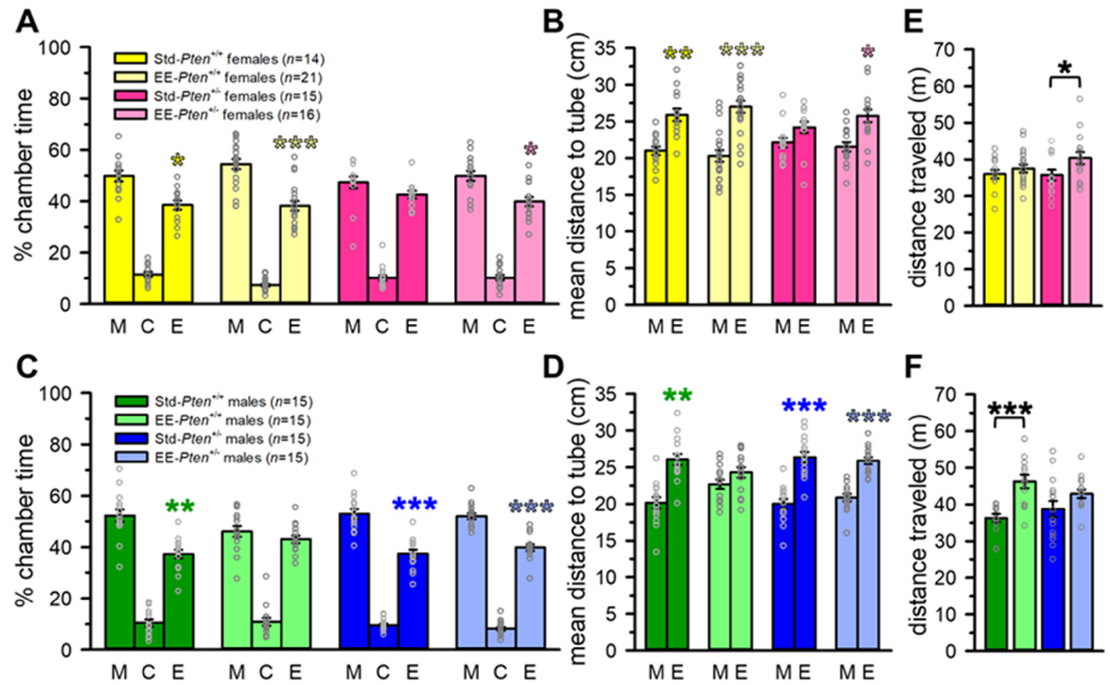
Figure 2. Environmental enrichment rescued social approach deficits in Pten +/ − females. ( A , B ) All females except for Std- Pten +/ − mice showed a preference for the social chamber ( A ) and were, on average, closer to the tube with a social stimulus ( B ). ( C , D ) All males except for EE- Pten +/+ mice showed a preference for the social chamber ( C ) and were, on average, closer to the tube with a social stimulus ( D ). ( E,F ) EE increased the distance traveled by Pten +/ − females ( E ) and Pten +/+ males ( F ). Mean ± SEM. Black symbols, difference between conditions. Colored symbols, within-group differences. *** p < 0.001, ** p < 0.01, * p < 0.05. M, mouse + tube chamber; C, center chamber; E, empty tube chamber; Std, standard housing; EE, environmental enrichment.